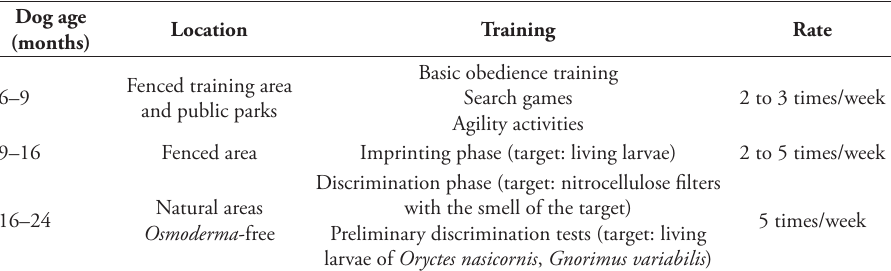
Table 1. Summary of the training progression of